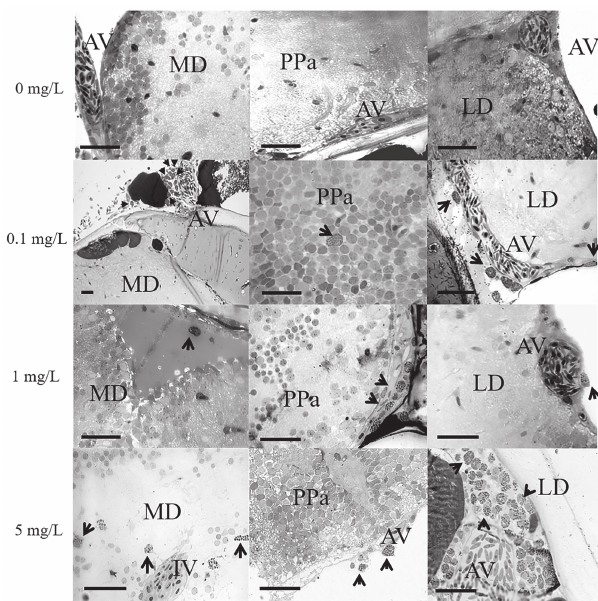
Fig. 2. Cross-sections of preoptic area (AP) of Paracheirodon axelrodi for different treatments with Roundup Activo™. MC cells are present at different AP nuclei in all treatments. Mid dorsal telencephalic nucleus (MD). Anterior preoptic parvocelular nucleus (PPa). Lateral dorsal telencephalic nucleus (LD). Adjacent blood vessels (AV) and internal blood vessels (IV) are shown. MC cells are shown by black arrows. Technique: high resolution optical microscopy (HROM). Bar 25 μm.